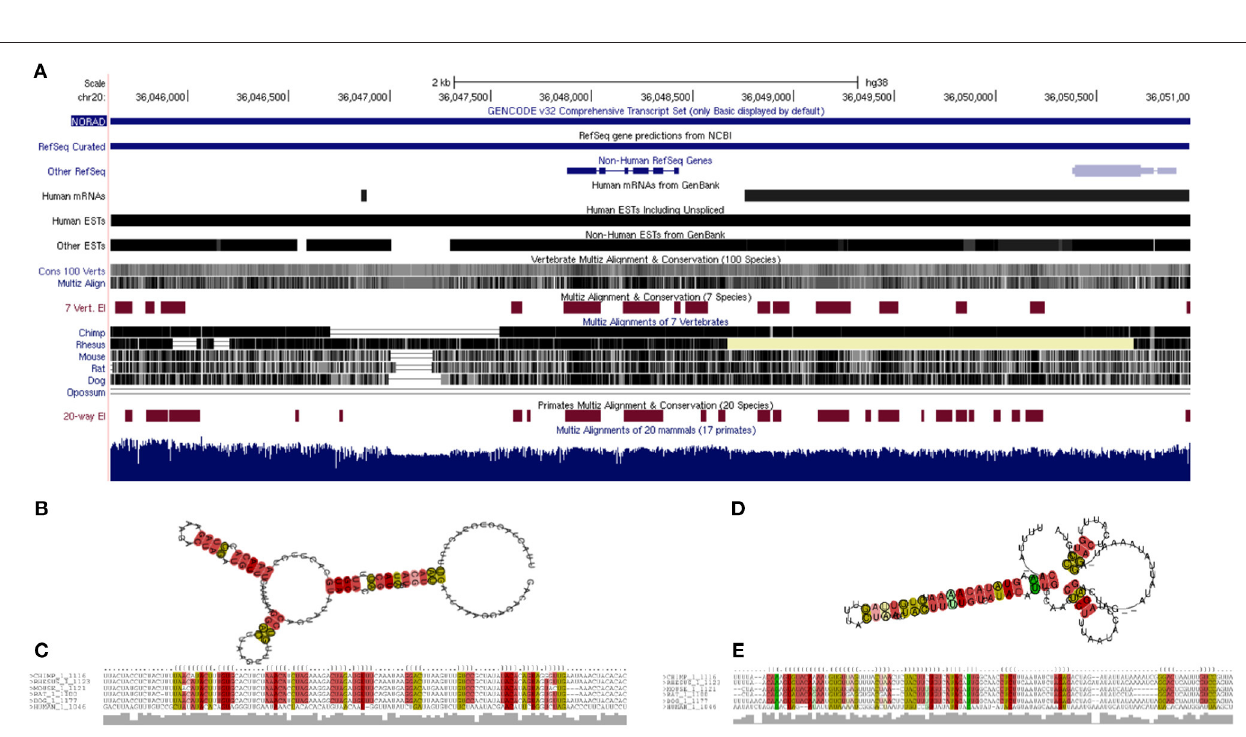
FIGURE 6 | Annotated reference sequence of human lncRNA NORAD, its genomic and expressed sequence tags (ESTs) conservation across the mammalian genome (A) ; thermodynamically stable and evolutionarily conserved RNA-fold from multiple sequence alignment of six mammalian NORAD genomic sequences with probabilities of 0.92 (B) and 1.0 (D) , respectively; multiple sequence alignment of six mammalian NORAD genomic sequences used for predicting secondary structures; colors show mutational pattern with respect to the structure (C,E) . Pale color indicates a base pair cannot be found in some alignment.